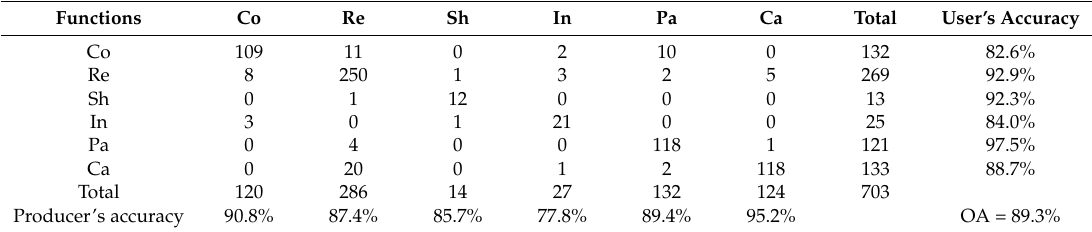
Table 5. Confusion matrix of functional-zone classification results. Co = Commercial zones; Re = Residential districts; Sh = Shanty towns; In = Industrial zones; Pa = Parks and greenbelt; Ca = Campuses; and OA = Overall accuracy.